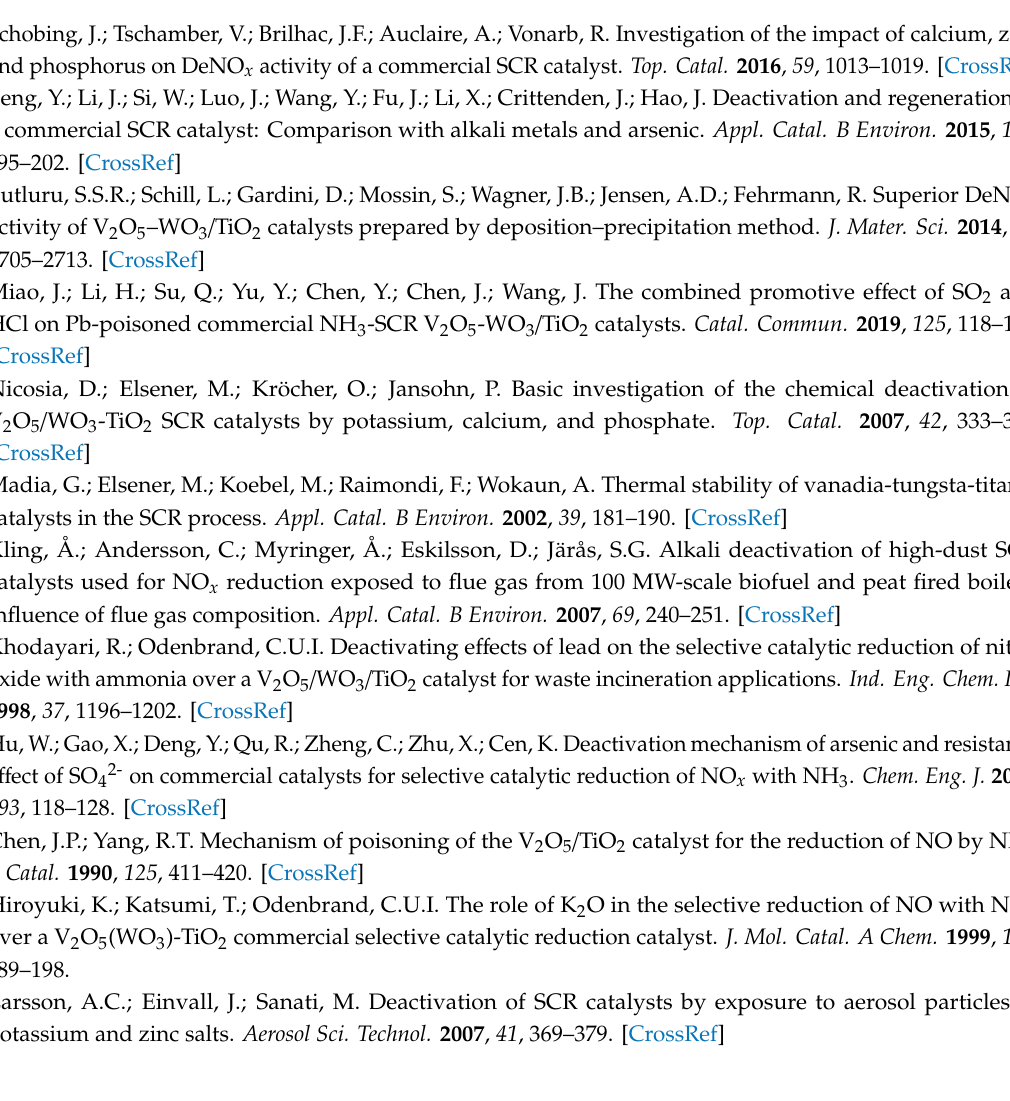
Figure S1: (a) The N 2 selectivity of fresh and poisoned samples; (b) the N 2 selectivity of fresh and poisoned samples at 350 ◦ C with time, Figure S2: The SEM-EDS images of fresh and poisoned catalyst, Figure S3: N 2 adsorption-desorption isotherm of fresh and poisoned samples, Figure S4: The pore size distribution of fresh and poisoned samples, Figure S5: The SEM images of fresh catalysts and poisoned samples, Figure S6: XPS spectra of the W 4f of fresh and poisoned